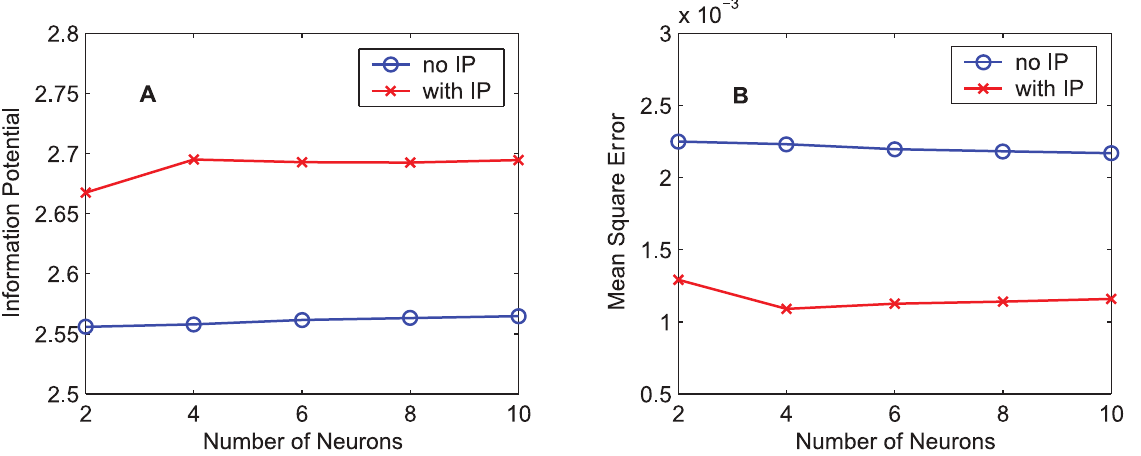
Figure 16. Relation between the training result and the number of neurons of the RNN. Training results after 1000-epoch training for the case of the training data set ‘‘MG’’ are presented. The circle markers denote the results obtained by the MEE algorithm, and the cross markers denote the results obtained by the synergistic algorithm. (A) Results of the quadratic information potential. (B) Results of the mean square error.